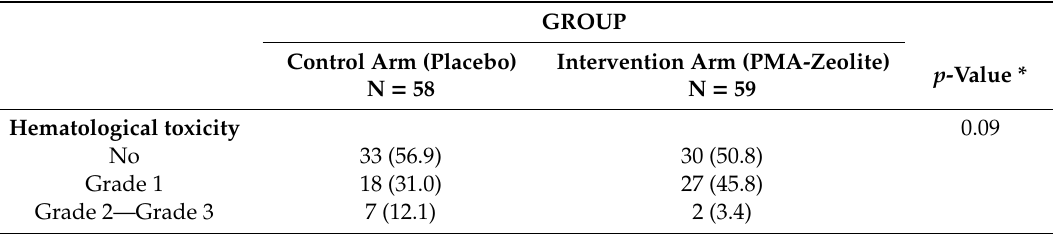
Table 5. Hematologic toxicity—univariate